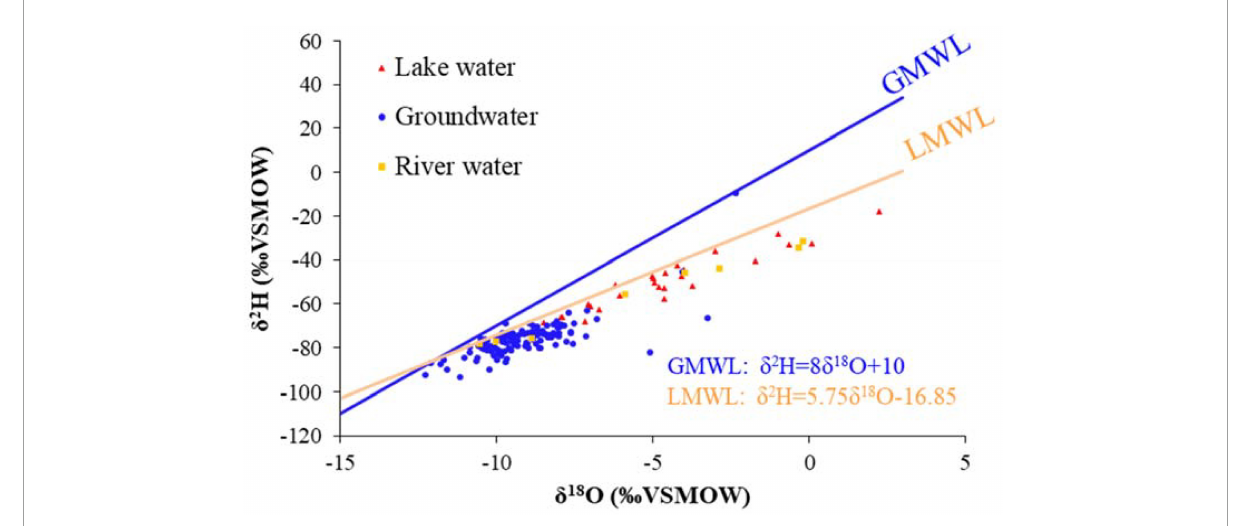
FIGURE3 Relationship between δ 18 O and δ 2 H in different water bodies within